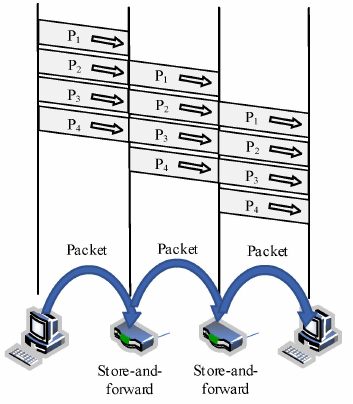
Figure 2. The whole process of packet